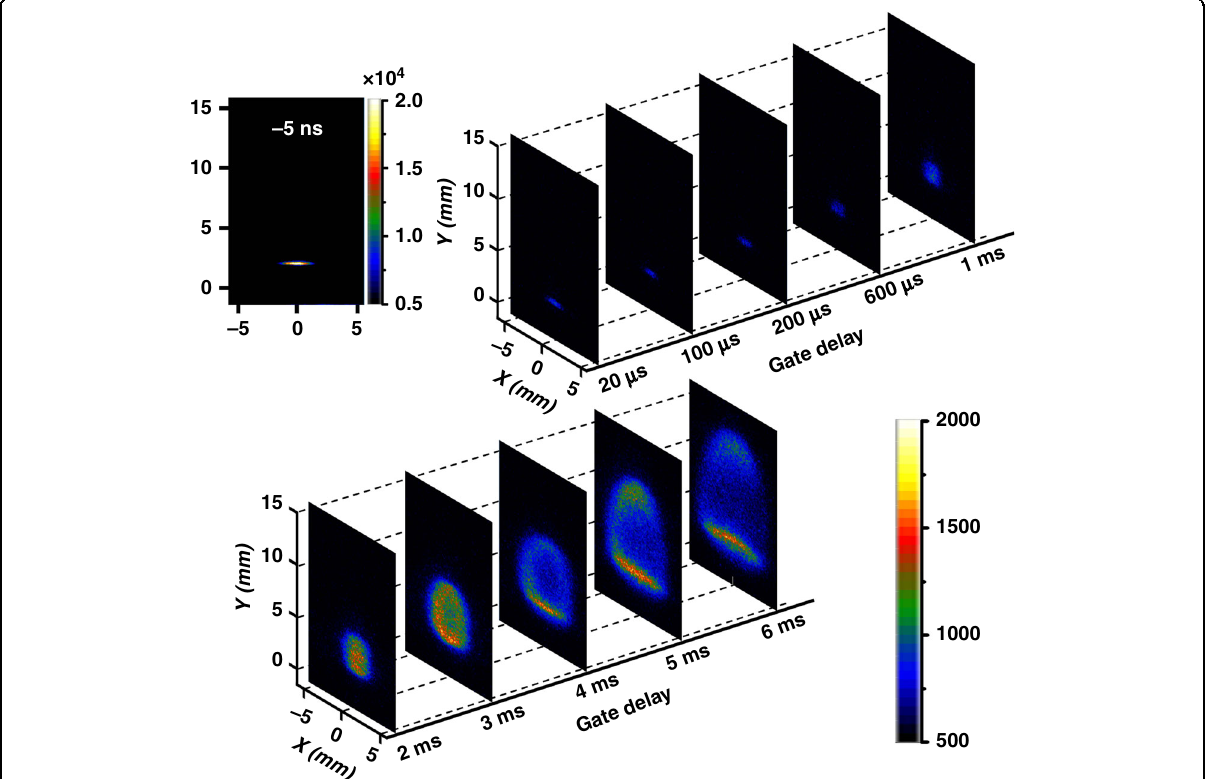
Fig. 2 Temporal ignition evolution. Side-view images for the dynamic evolution of the fl ame kernel ignited by the fs laser fi